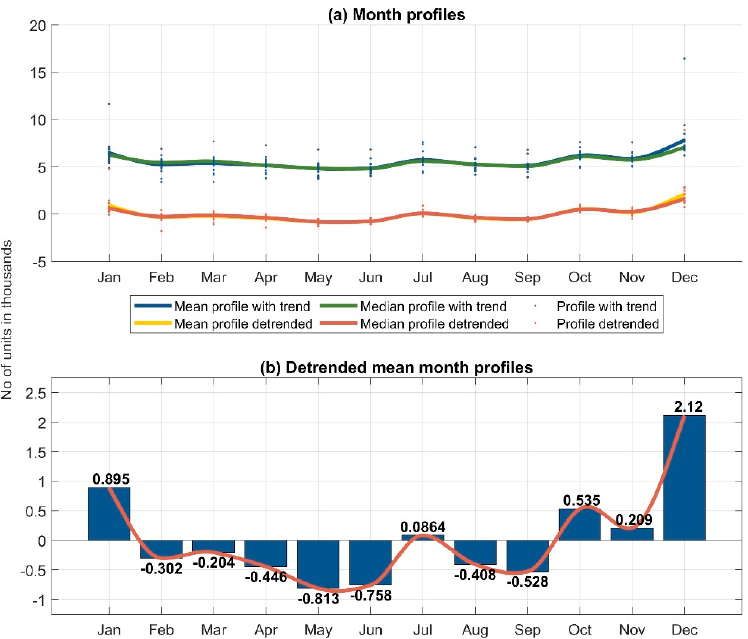
Figure 8. Averaged annual profile. Housing units completed—individual (Source: own compilation based on data from CSO). based on data from